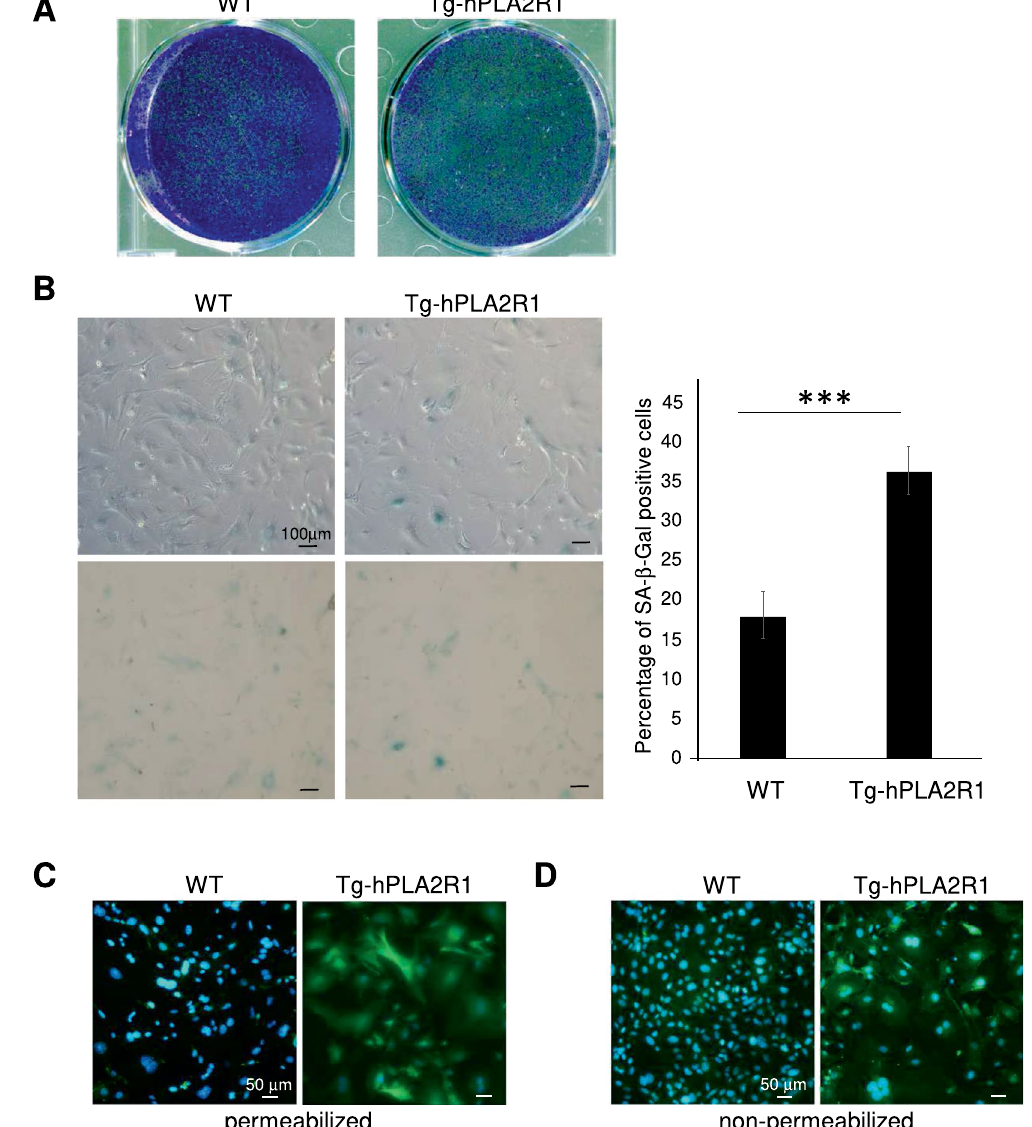
Figure 4. Tg-hPLA2R1 derived MEFs senesce prematurely. ( A) Indicated MEFs were seeded at the same cell density and were PFA-fixed and stained by crystal violet 9 days later ( A ) or analyzed for SA- β -Gal activity 7 days later ( B ). Representative photographs and percentage of stained cells (means + / − SD, and p-value using student t-test, *** P < 0.005) are shown. ( C ) Cells were methanol fixed (permeabilized conditions), or ( D ) fixed using PFA (non-permeabilized conditions), and ( C , D ) IF against PLA2R1 was performed. Nuclear counterstaining was performed using Hoechst